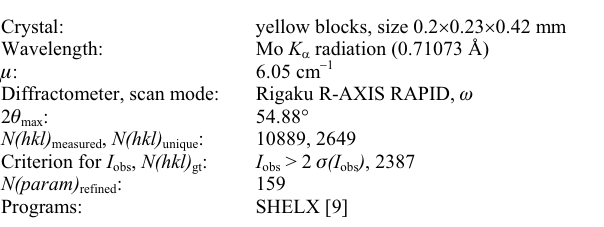
Table 1. Data collection and handling.